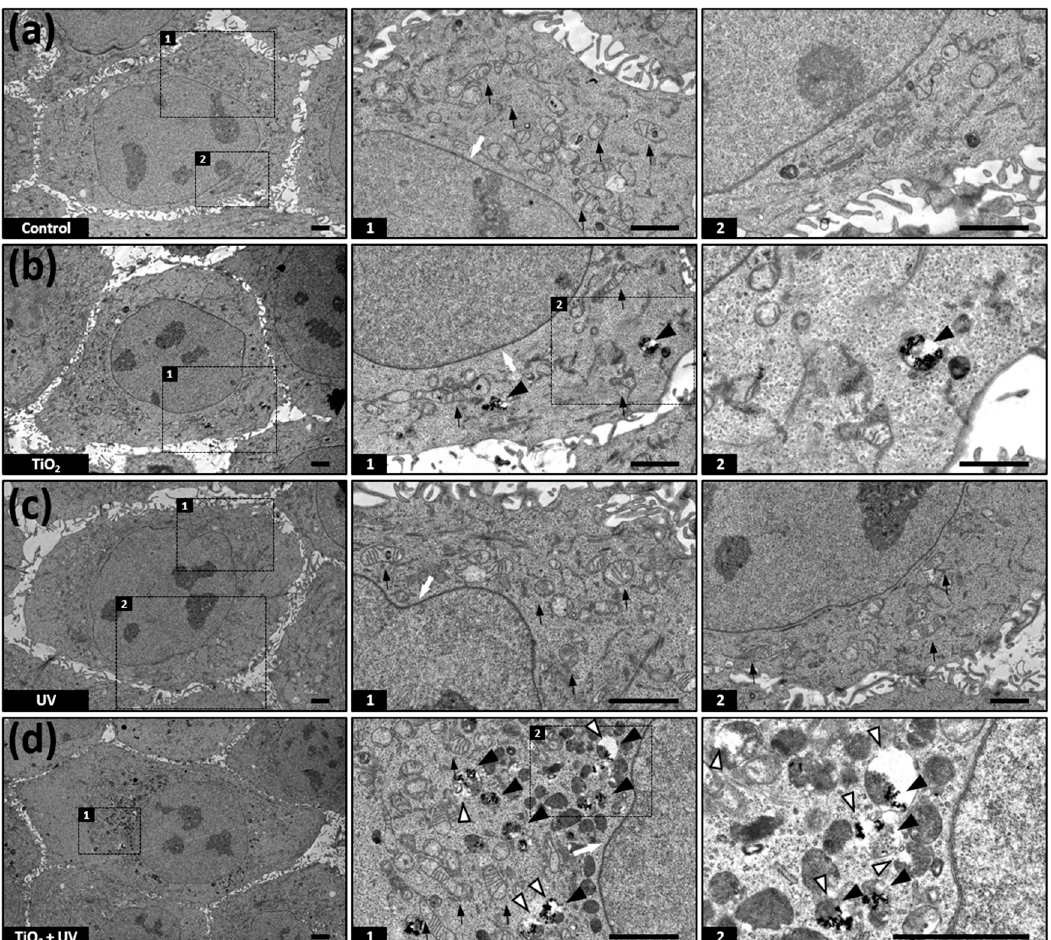
Figure 5. Transmission electron microscopy of HaCaT cells treated with TiO 2 NPs and UVA: ( a ) untreated cells; ( b ) cells treated with TiO 2 NPs alone; ( c ) cells irradiated with UVA for 20 min; ( d ) cells cotreated with TiO 2 NPs and UVA. Scale bars correspond to 2 μ m. Black arrowhead, phagosome-like structures; black arrow, mitochondria; white arrow, nuclei; white arrowhead, ruptured lysosome.